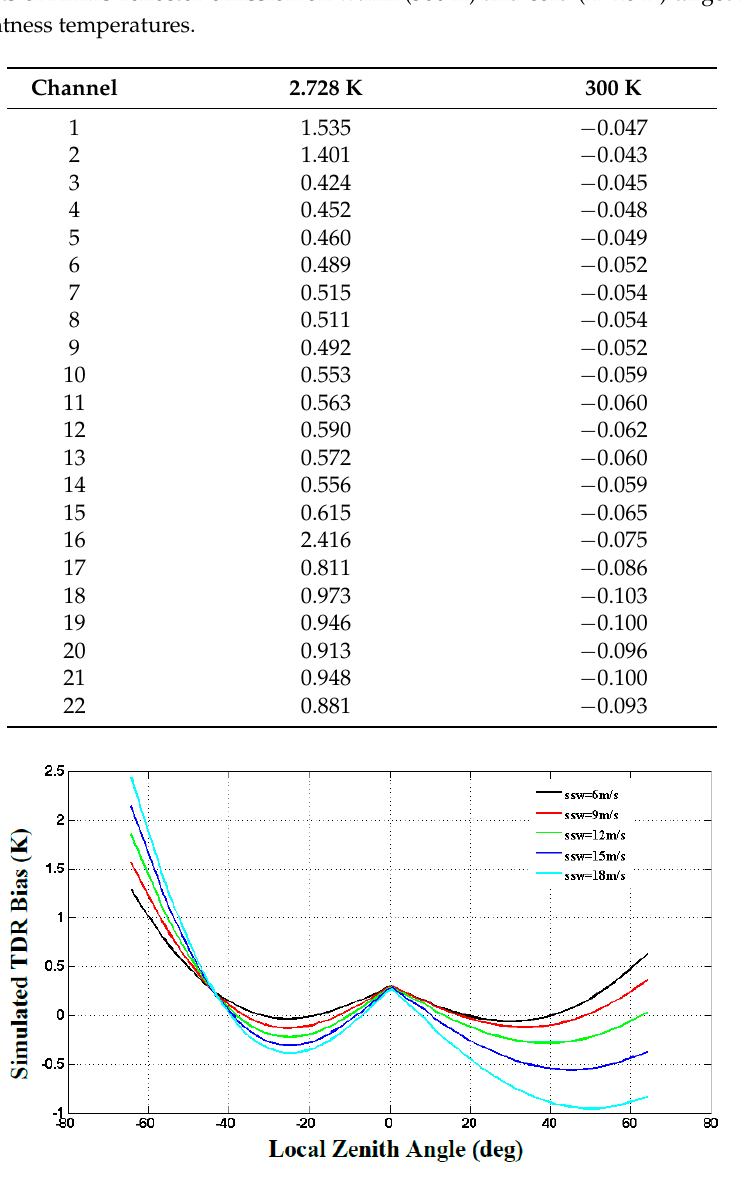
Figure 6. Biases of ATMS antenna brightness temperature at channel 1 as a function of local zenith angle over oceans. Surface wind speed varies from 5 to 18 m/s. Reflector temperature is assumed as 283 K and its emissivity of 0.0028.